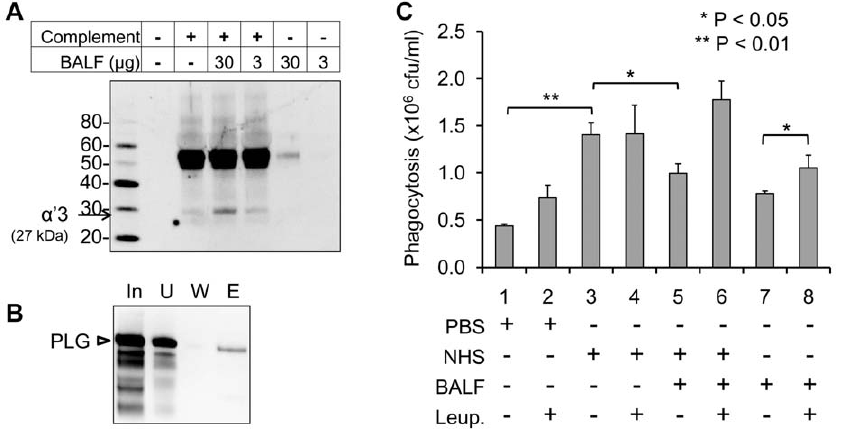
Figure 7. Rabbit BALF decreases spore phagocytosis of macrophages. (A) Rabbit complements were incubated with BALF (3 and 30 m g) in the PBS for 1 h and subjected to Western blot analysis with anti-C3b antibody. Degradation of C3b was indicated by arrow (27 kDa of a 9 3 chain). (B) PLG in the BALF interacts with spores. BALF was incubated with spores, eluted by a chaotropic salt and subjected to Western blot analysis with anti- rabbit PLG antibody. (C) BALF decreases NHS-mediated spore phagocytosis. RAW264.7 cells were infected with NHS-treated spores in the presence of BALF and/or leupeptin. Phagocytosed spores were determined by a serial agar plating method.